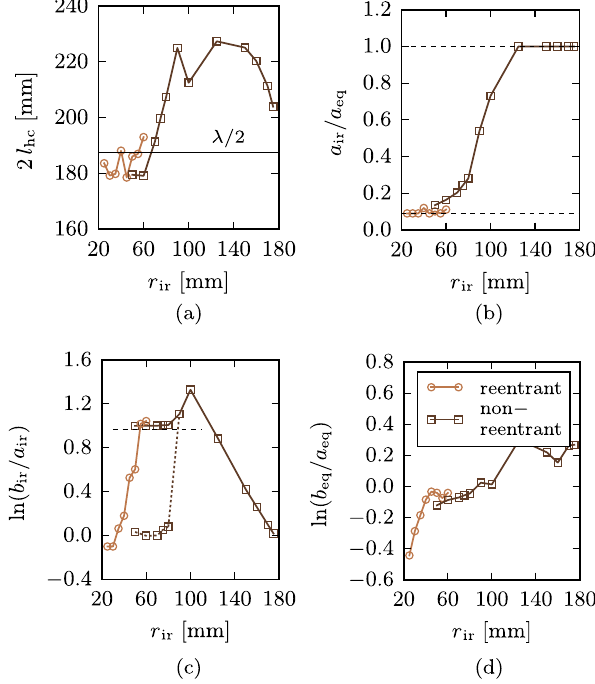
FIG. 7. Optimized cavity parameters as functions of the iris radius r . (a) Cavity length. (b) Ratio between iris and equator ir ellipse by means of their horizontal half axes. Due to mechanical constraints, this ratio is limited. (c) — (d) Logarithmic ratio between the vertical and horizontal half axis (ellipticity) for the iris and equator ellipse.